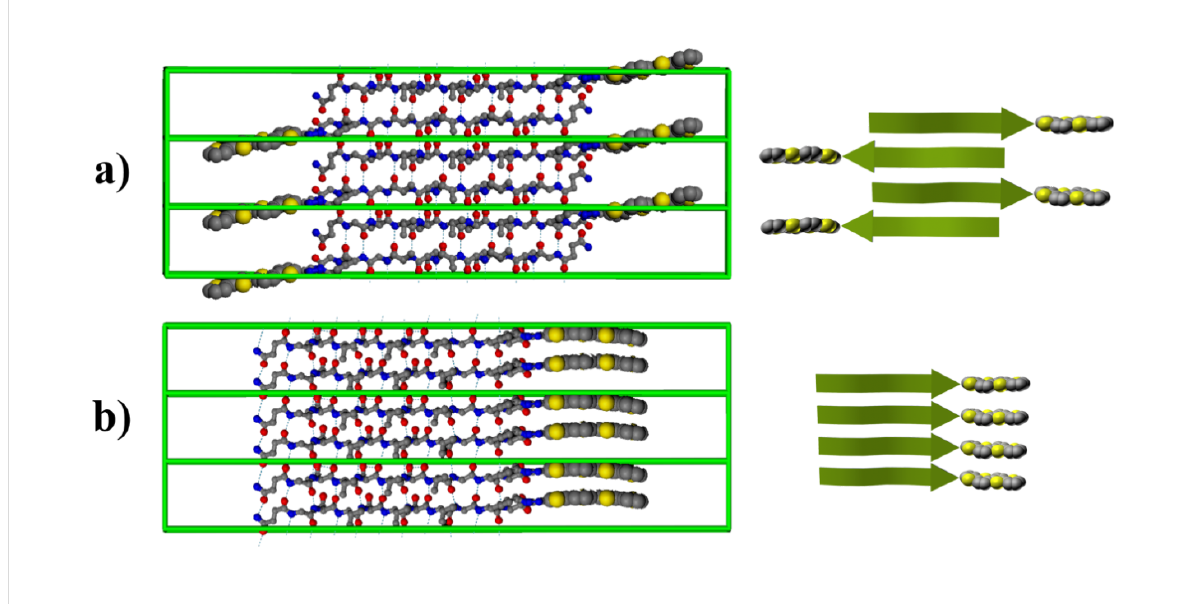
Figure 12: Constructed periodic crystalline cells for (a) antiparallel and (b) parallel arrangement of peptide strands in single-layer fibrils. Alkyl chains are not shown. Dashed lines represent the hydrogen bonds responsible for β -sheet formation. Right insets present the principal arrangement of peptide and thiophene moieties [23].